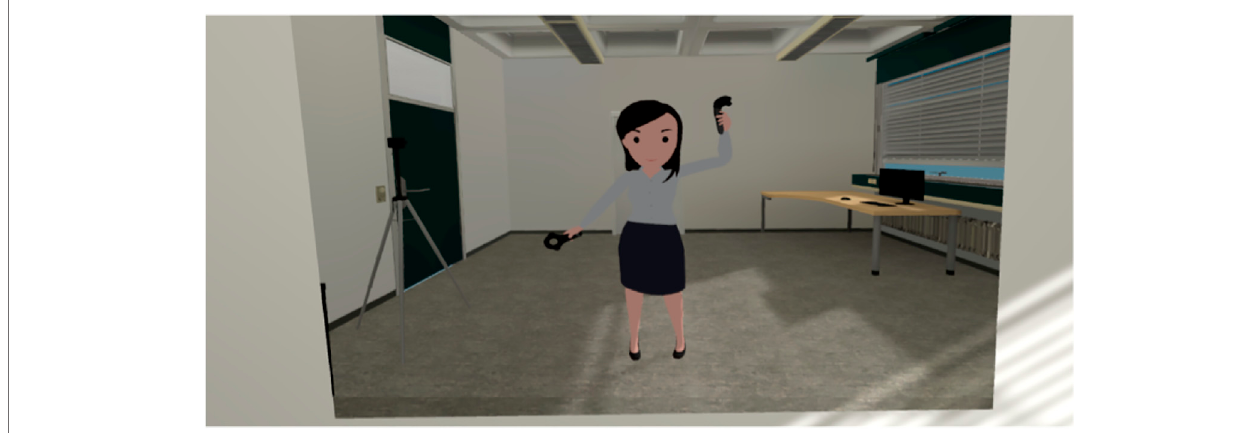
FIGURE 9 | Participants performed body movements in front of a virtual mirror to acclimatize themselves.